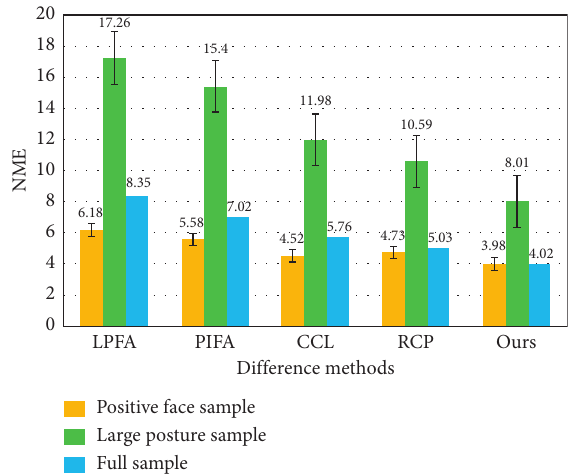
Figure 4: Experimental results of different alignment